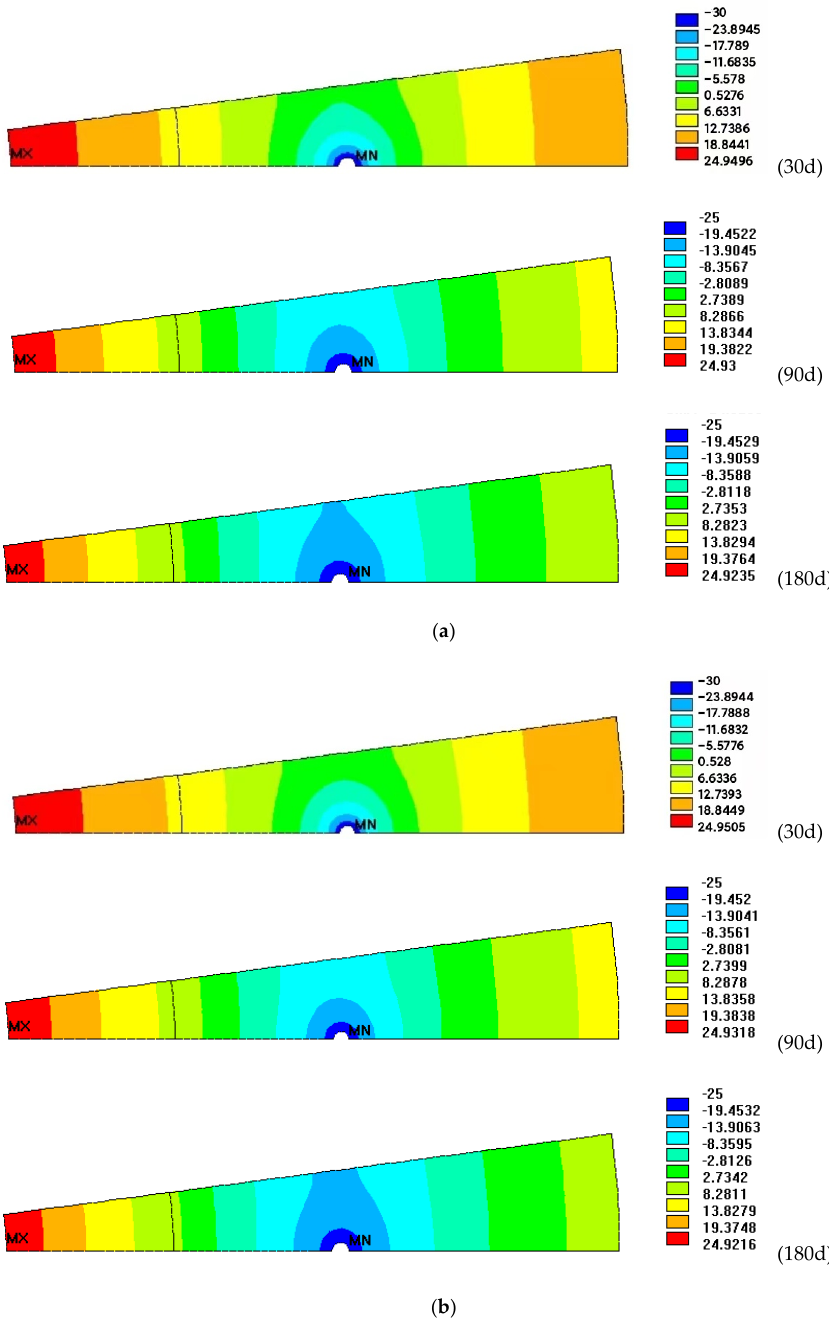
Figure 15. Temperature contours within 30 d, 90 d, and 180 d: ( a ) freezing tube diameter of 140 mm, ( b ) freezing tube diameter of 159